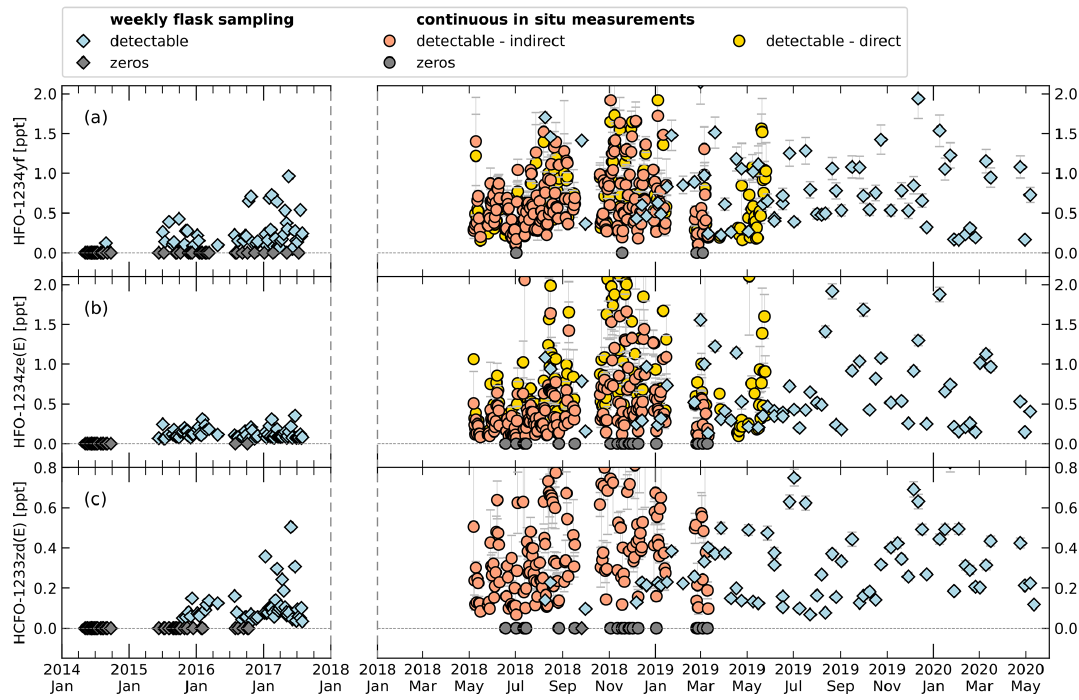
Figure 10. Same as Fig. 9 but zoomed in to visualise small mole fractions better.